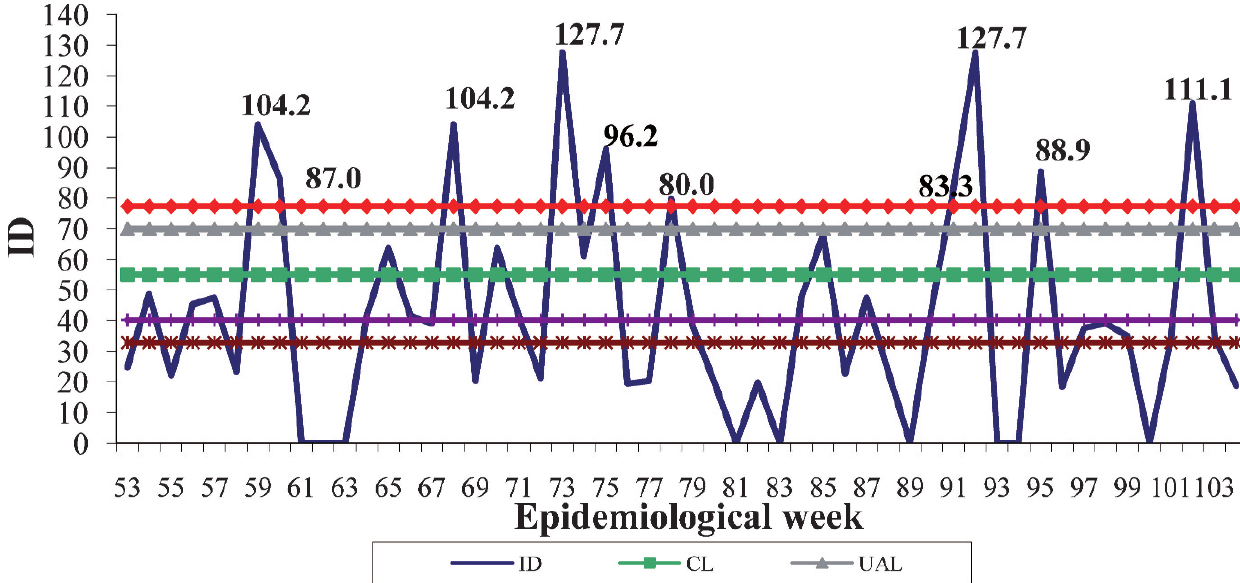
Figure 1 - The control chart of the incidence densities per 1,000 patients/day in 2005 (Shewhart chart proposed by Arantes). (1) The year 2004 was used as the basis when building the limits. (2) The limit values were as follows: CL=55.11, UAL=69.96, UCL=77.39, LAL=40.27 and LCL=32.84. (3) The limits were built based on the Poisson distribution, considering the deviation as the square root of the weekly nosocomial infection incidence average.